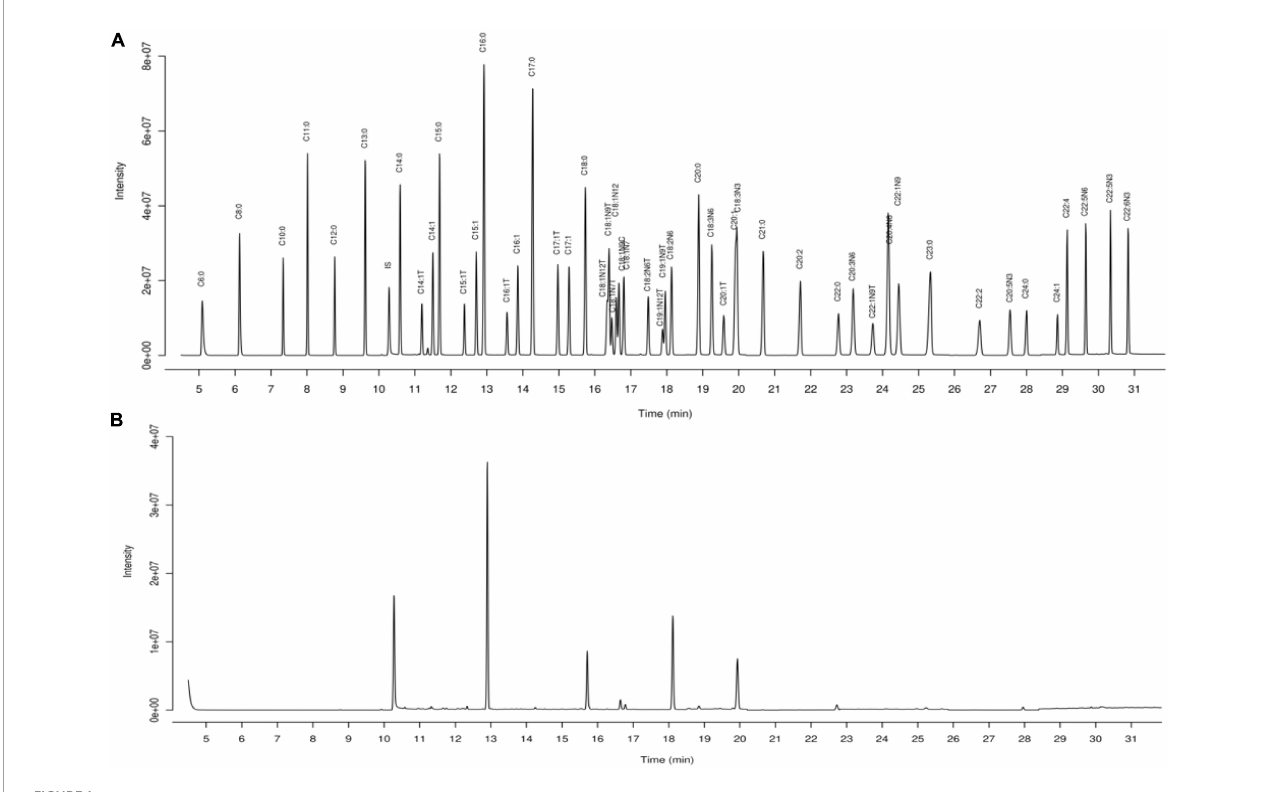
FIGURE1 Total ion flow chromatogram of mixed standard (A) and sample (B) .